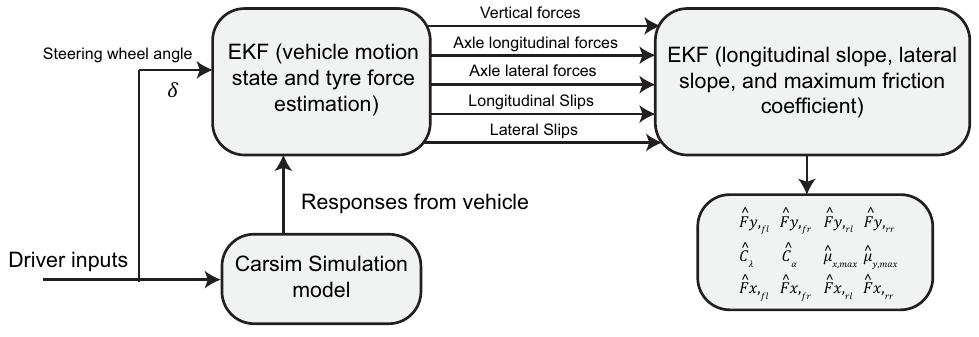
Figure 14. Estimation structure proposed by Qi et al. [101]. Figure adapted by the authors from